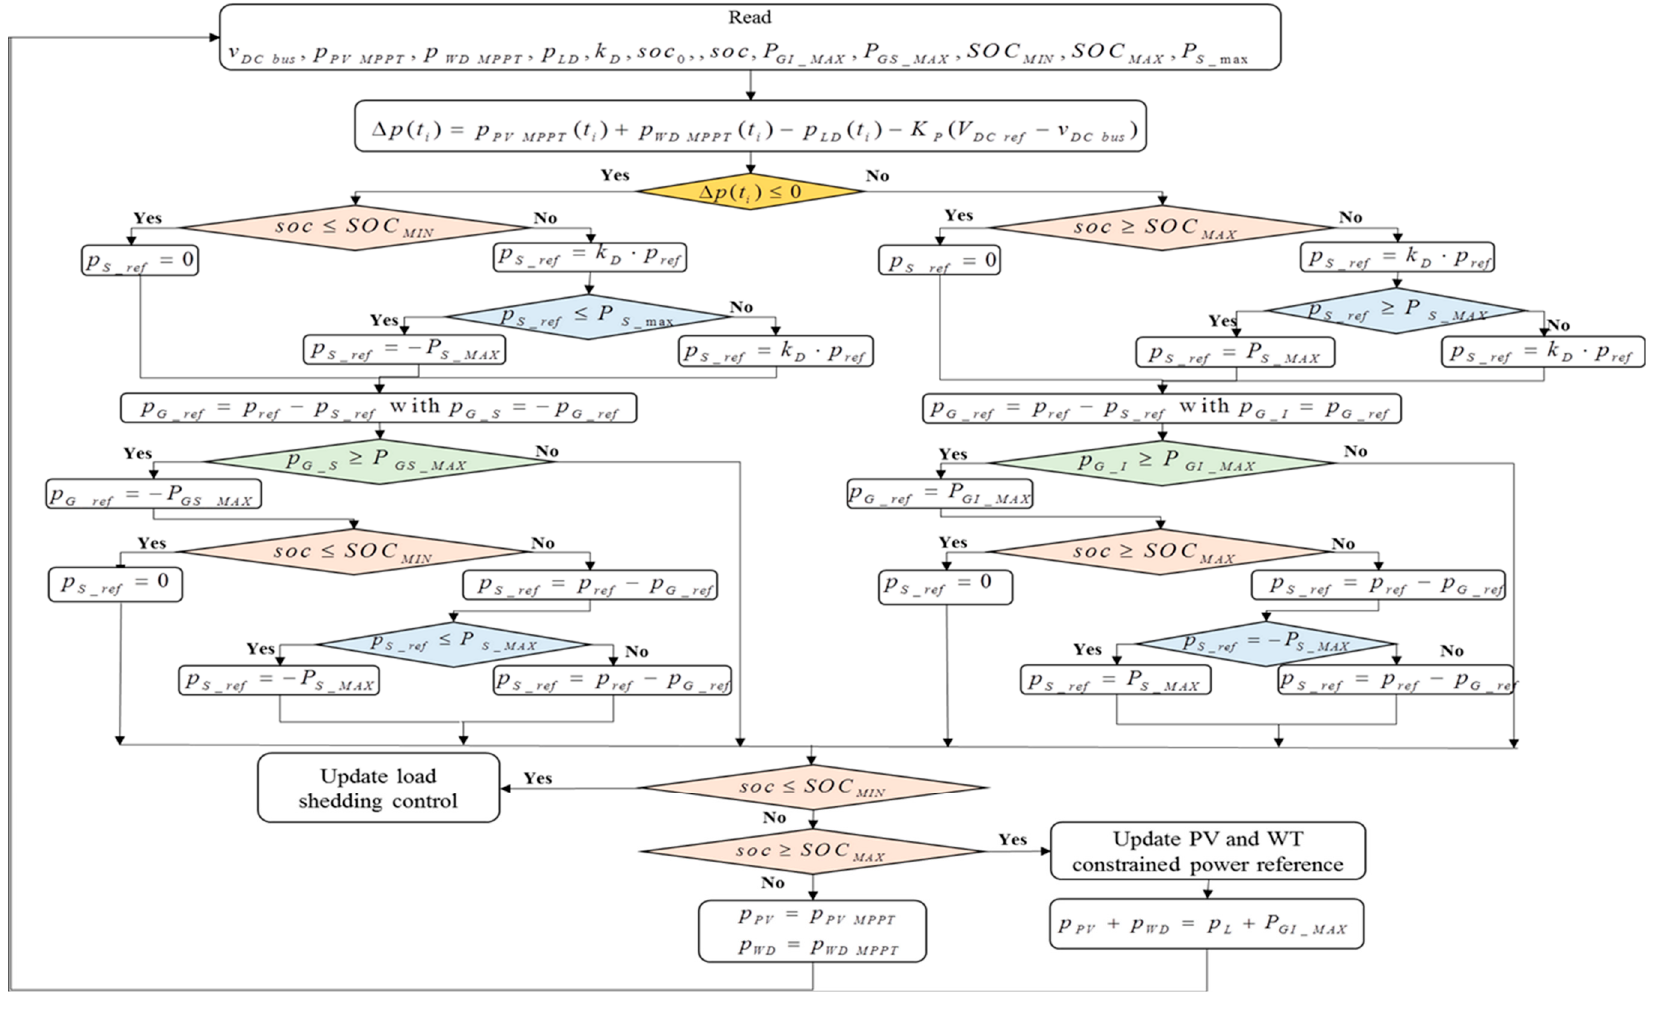
Figure 3. Flowchart of power management of the DC MG in power management layer.